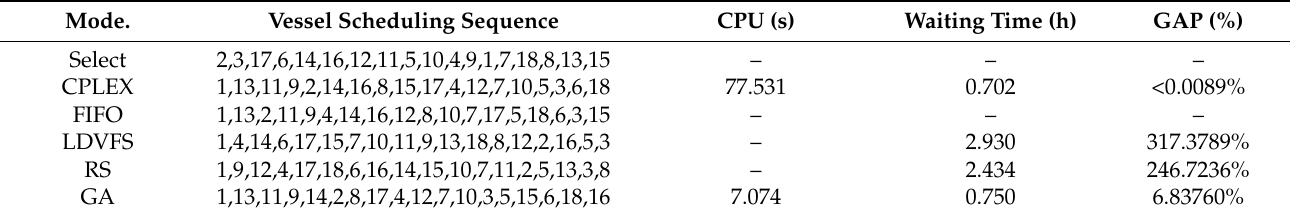
Table 12. Comparisons between CPLEX, FIFO, LDVFS, RS, and GA of instance “Inst_18_1”.